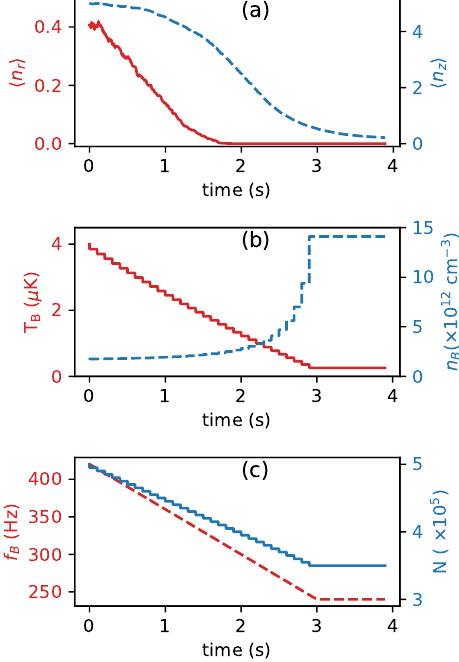
Figure 4. Trapped atom interacting with a bath that is undergoing fast evaporative cooling for three seconds. ( a ) Radial and axial mean vibrational occupation numbers are shown by red solid and blue dashed lines, respectively. Here, the final occupation numbers are (cid:104) n (cid:48) r (cid:105) = 0.00 and (cid:104) n (cid:48) z (cid:105) = 0.23, meaning that the atom always ends up in the ground state of the radial direction. ( b ) The temperature and the atomic density of the bath atoms are shown by red solid and blue dashed lines, respectively. ( c ) The red dashed line shows the change in the trapping frequency of the bath ( f B ) and the blue solid line shows the variation in the bath atom number. Here, ω / ( 2 π ) = 100 kHz, a = 160 a 0 , η y = 0.98, and η z = 0.105 for all